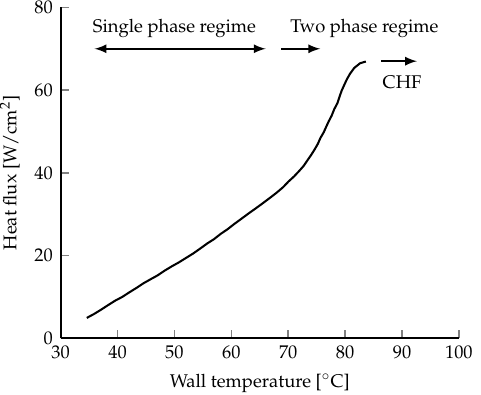
Figure 12. Typical spray cooling curve (FC-72, 93 mL/min, 1.0 bar, T sat = 57 ◦ C, ∆ T sub = 28 ◦ C, 2 cm 2 copper heater). Retrieved from [173].